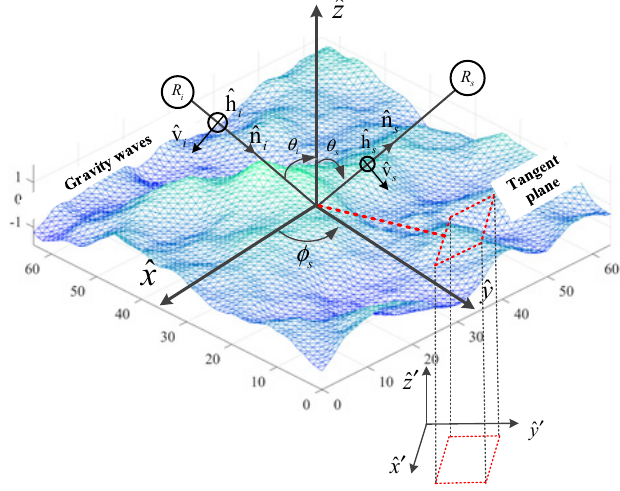
Figure 4. Quasi-specular scattering mechanisms for large-scale gravity waves.